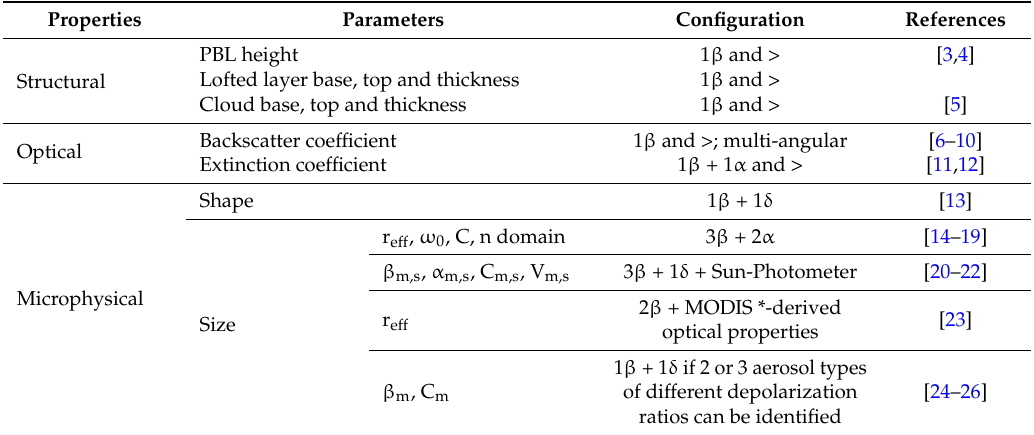
Table 1. Aerosol properties that can be retrieved from aerosol lidar measurements. An a β + b α + c δ system is formed by a elastic channels, b Raman channels and c depolarization channels. r eff is the effective radius of the aerosol size distribution, ω 0 the single scattering albedo, C the mass concentration, V the volume concentration and n the refractive index. The suffix m indicates the size distribution mode (fine or coarse) and the suffix s indicates the sphericity of the particles (spherical or spheroid). * MODIS: Moderate Resolution Imaging Spectroradiometer on board NASA